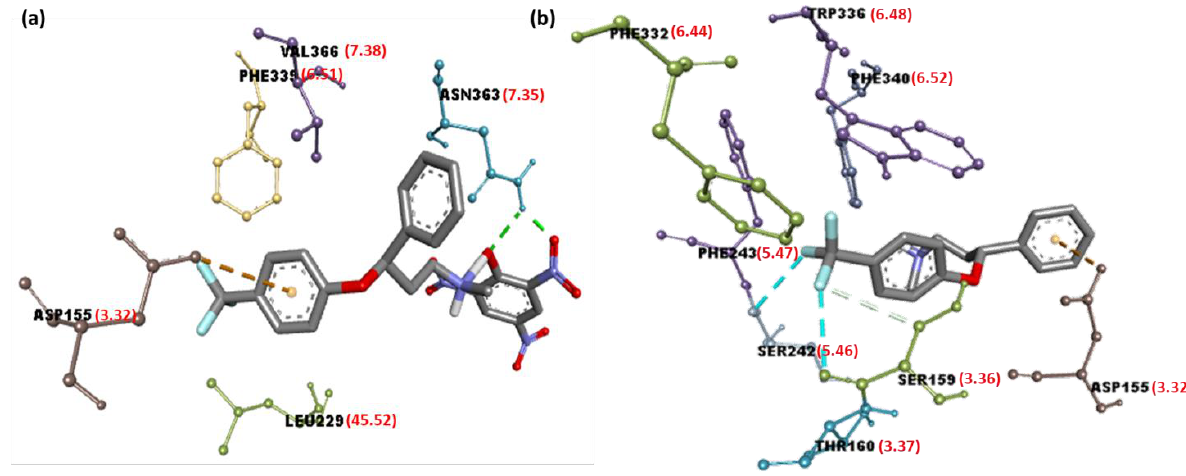
Figure 5. Best-docked pose showing a helical model of ( a ) [(FXN)(PA)] – serotonin; ( b ) (FXN) – sero- tonin. The 3D illustrations of the interactions between [(FXN)(PA)]–serotonin or (FXN)– serotonin are presented in Figure 6a,b.